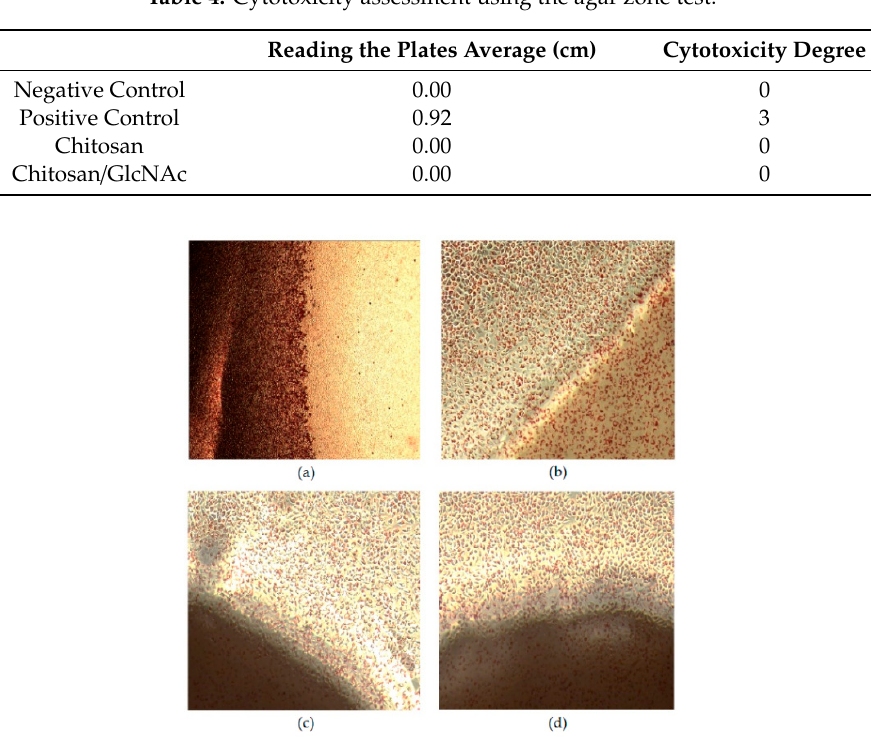
Figure 8. Phase contrast microscopy images of L929 cells after incubation for 24 h: ( a ) positive control, ( b ) negative control, ( c ) CS filament, and ( d ) CS/GlcNAc filament. All of the figures are of the same magnification.